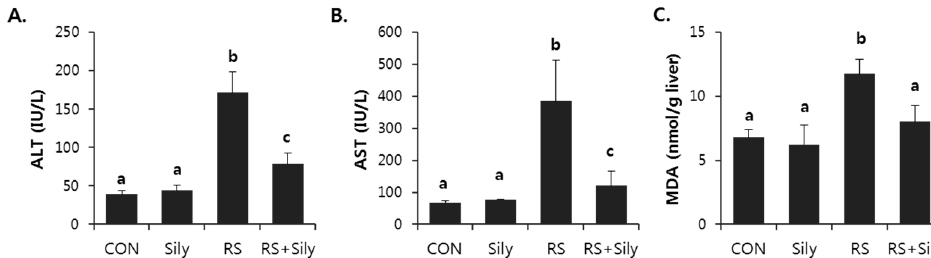
Figure 1. Silymarin inhibited restraint-induced acute liver injury. Serum activity of ALT ( A ) and AST ( B ), and hepatic level of MDA ( C ) were analyzed to examine liver injury. Each value is the mean ± SD for 4 mice. Values with different letters (a, b, c) are significantly different from one another (one-way ANOVA followed by Newman-Keuls multiple range test, p < 0.05). CON; control mice, Sily; only silymarin-treated mice, RS; restraint stressed mice, RS + Sily; restraint-stressed mice with silymarin treatment.